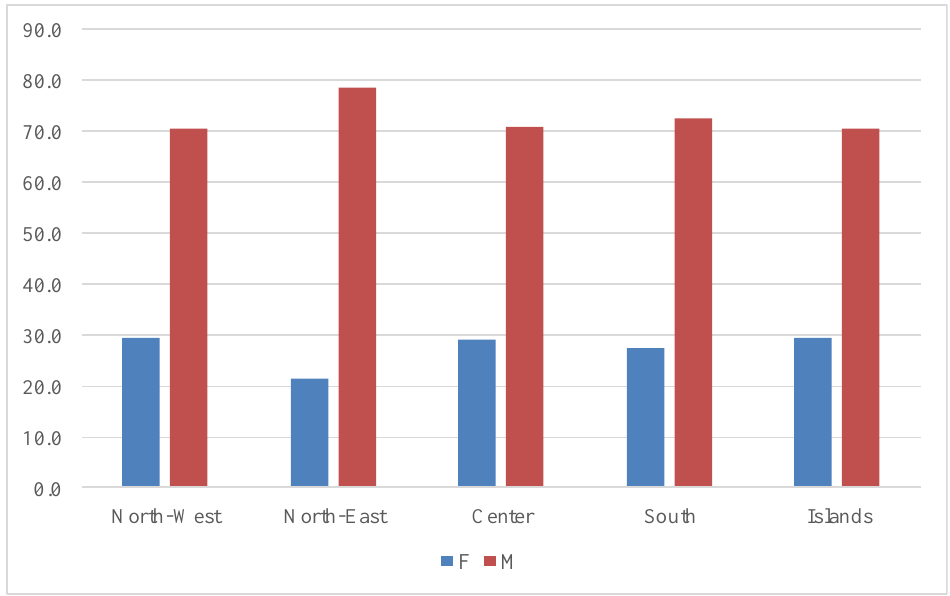
Figure 4. Percentage distribution of small farms by sex of tenants and by district. Source: Our elaboration on FADN data, 2018 – 2020.